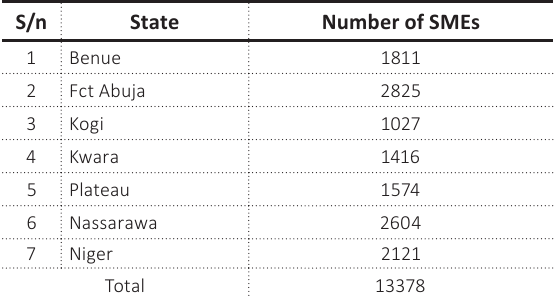
Table 1. Population of the study